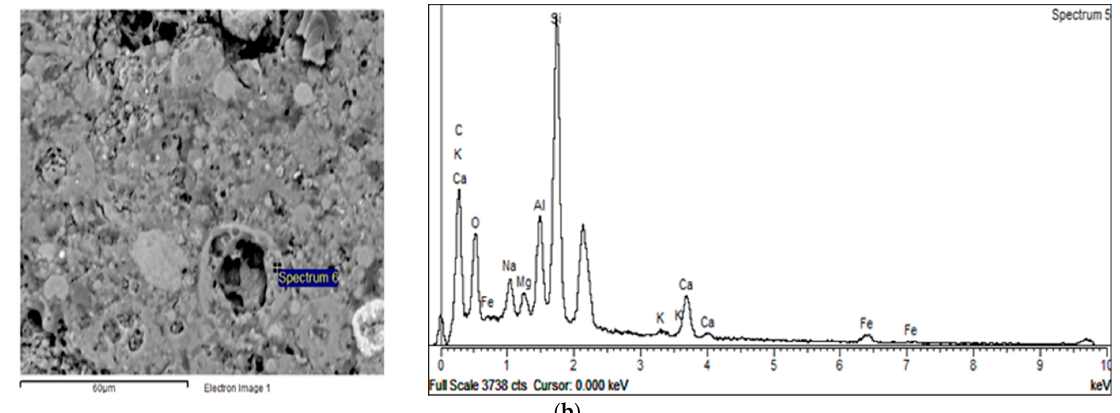
Figure 9. BSE ‐ EDS analyses of the VC 120 sample; ( a ) dissolved part of a parent fly ash particle and ( b ) particle shell richer in Al.